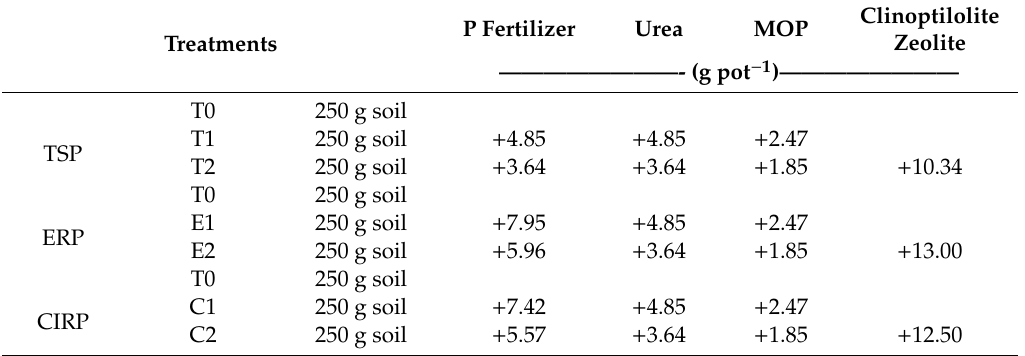
Table 2. Treatment evaluated in laboratory incubation